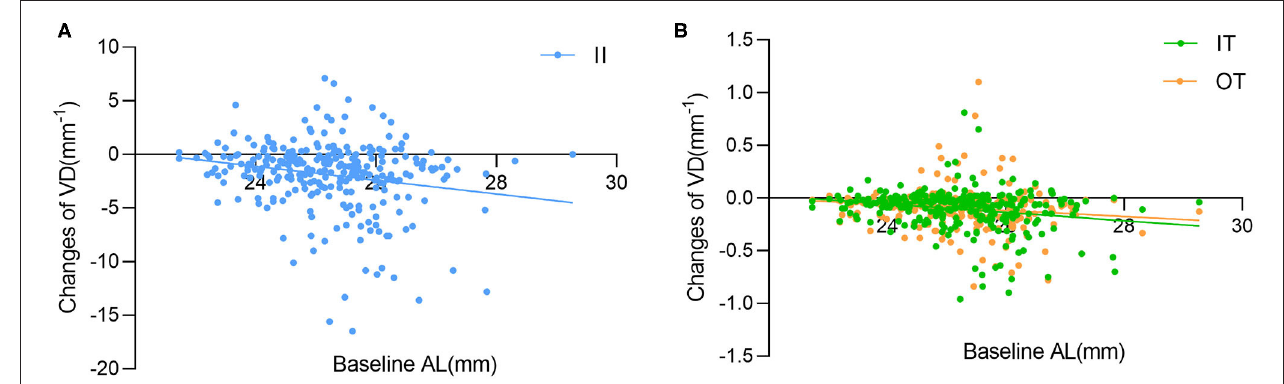
FIGURE 4 | Simple linear regression analysis between baseline AL with the changes of vessel density (VD) in the (A) inner inferior (II), (B) inner temporal (IT) and outer temporal (OT)